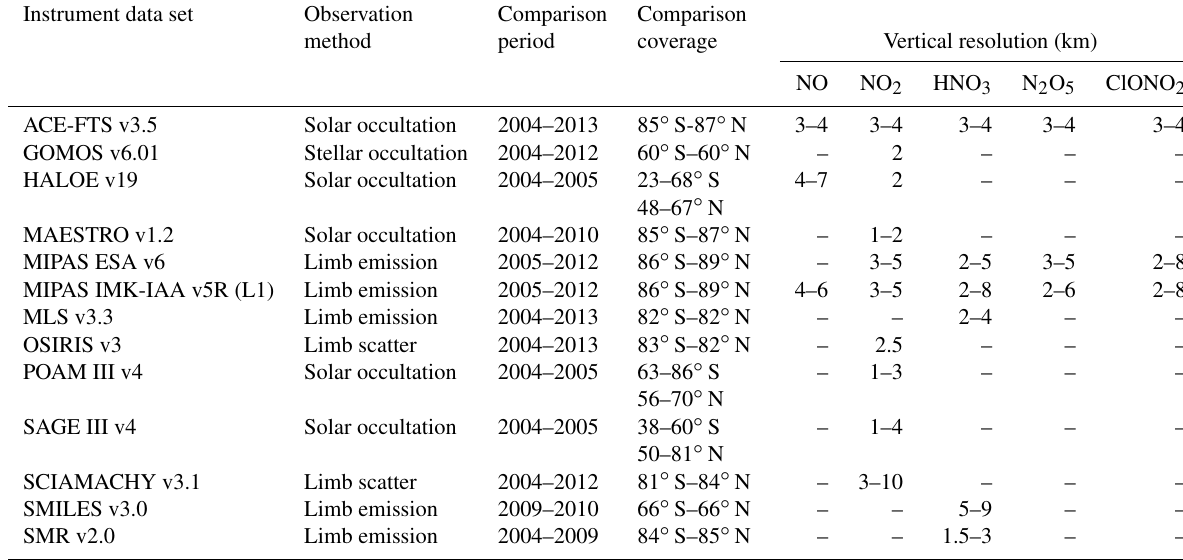
Table 1. Details of the instruments and the NO y data sets used in the comparisons. Instrument data set